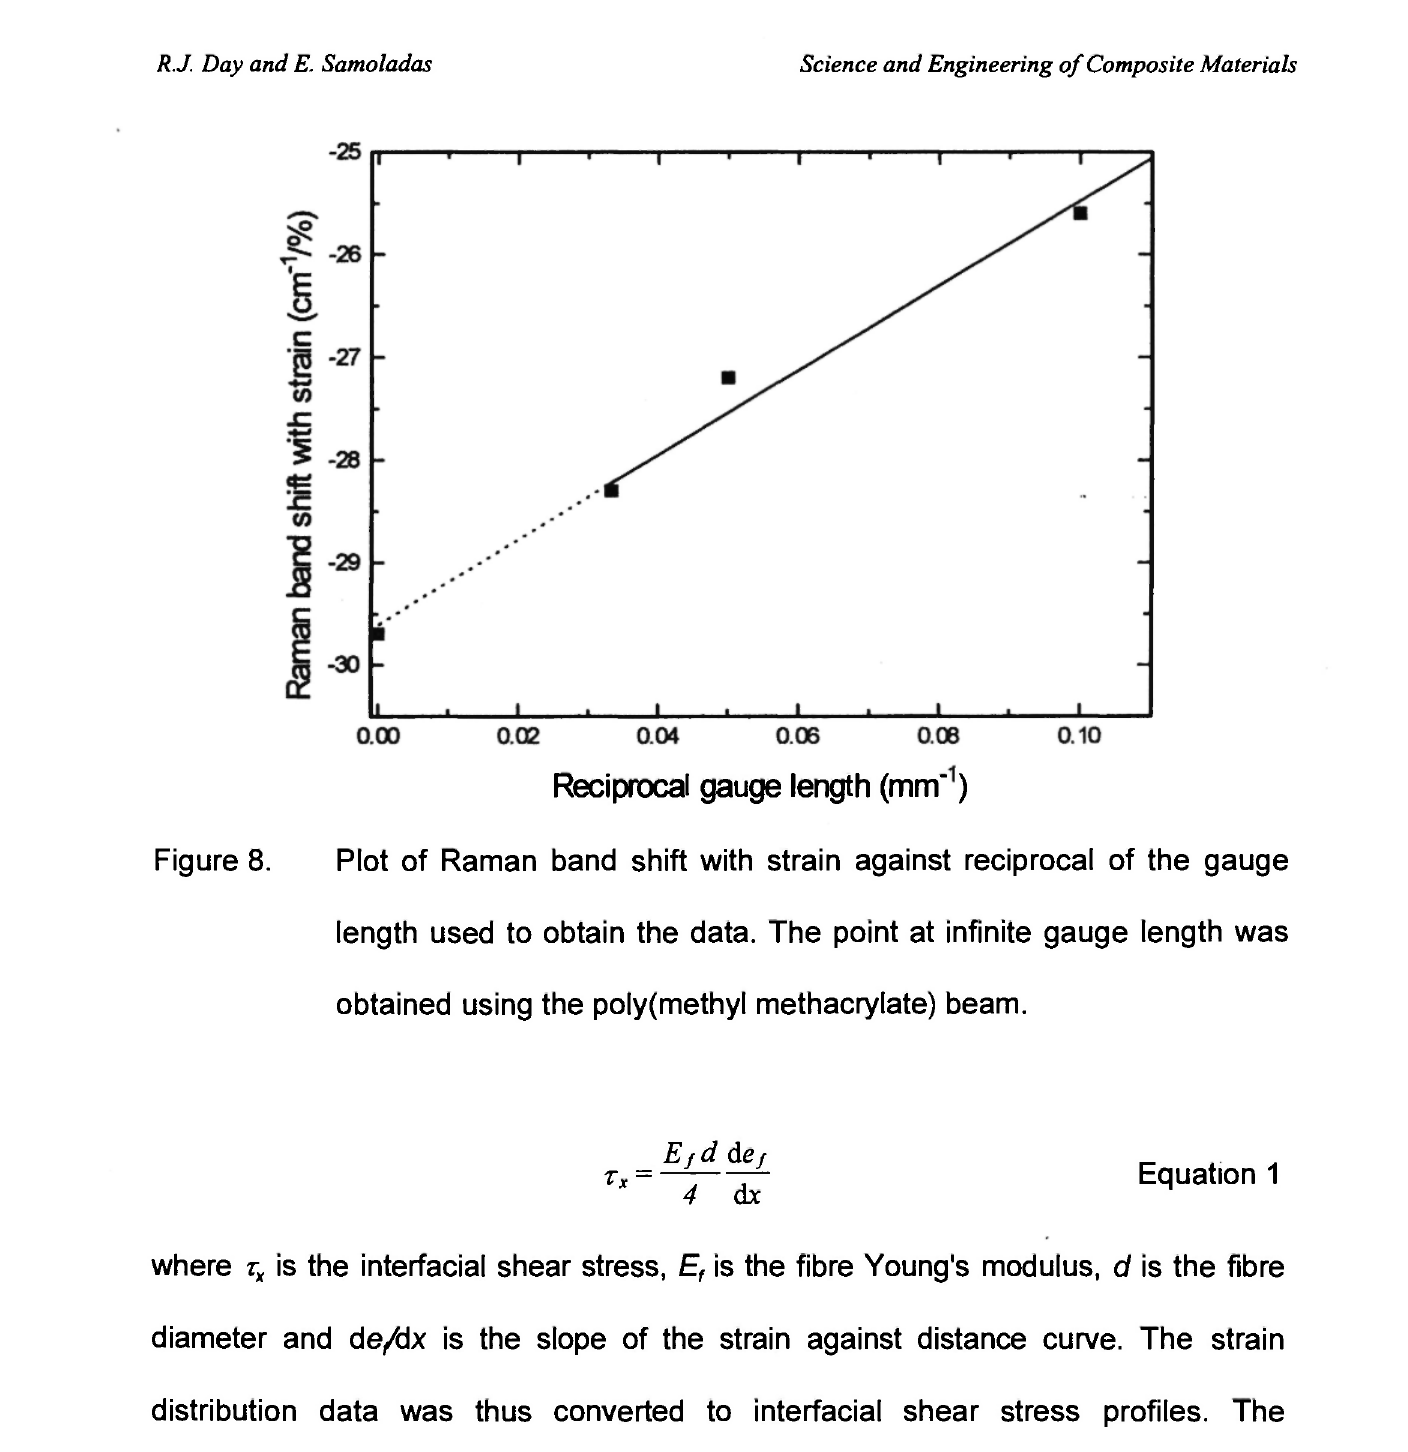
E d de f 7 τ = —, Equation 1 χ 4